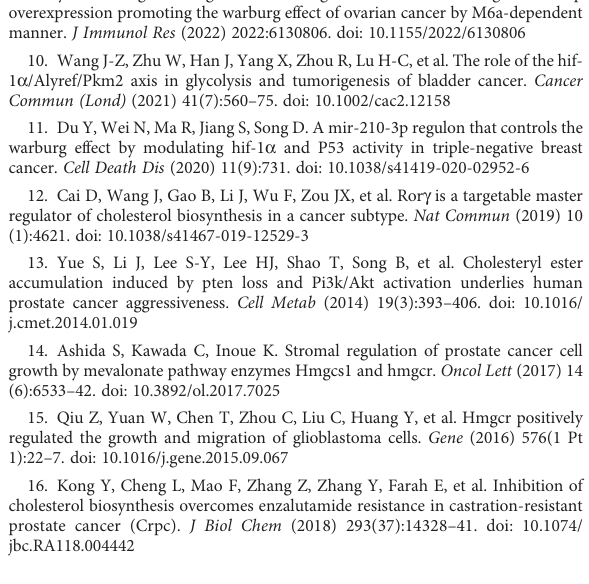
SUPPLEMENTARY FIGURE 2 Correlation between the expression of TRAM2 and survival prognosis in pan-cancer (A) Kaplan-Meier survival curves of the relationship between TRAM2 expression and overall survival in pan-cancer. (B) Kaplan-Meier survival curves of the relationship between TRAM2 expression and progression free survival in pan-cancer. (C) Kaplan-Meier survival curves of the relationship between TRAM2 expression and Disease speci fi c survival in